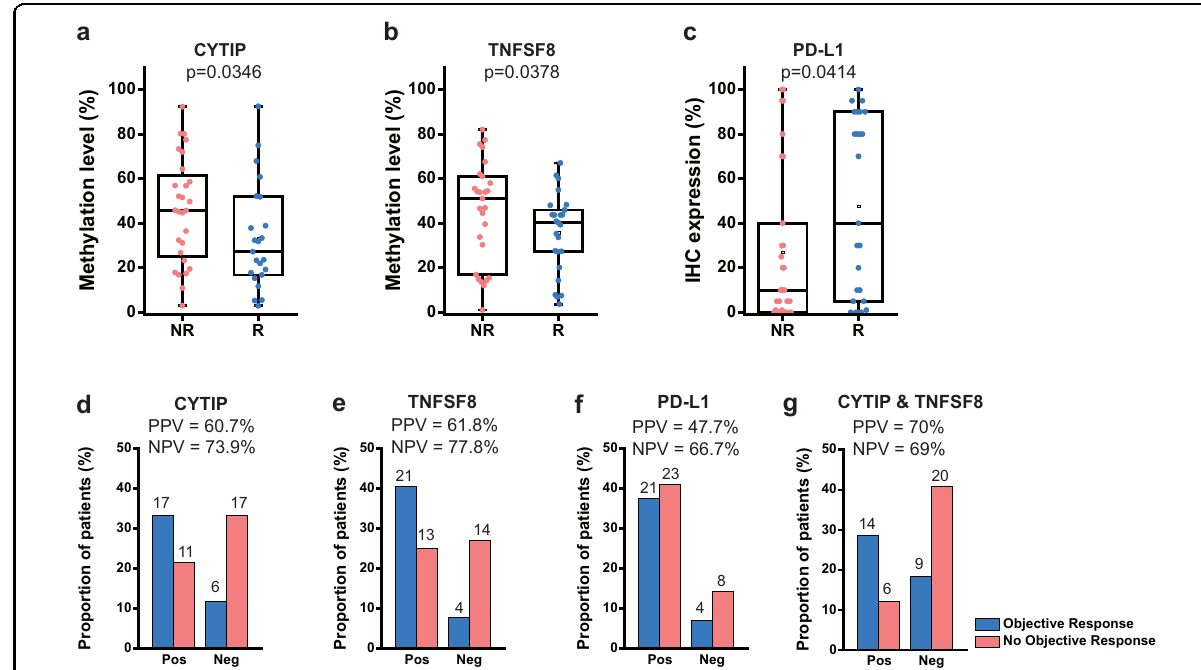
Fig. 4 Evaluation of pDMRs for CYTIP and TNFSF8 to predict the anti-PD-1 response. a , b Comparison of methylation levels of pDMR for CYTIP between responders (R) and non-responders a and those for TNFSF8 b in the validation cohort. c Comparison of the PD-L1 expression level between responders (R) and non-responders (NR) in the validation cohort. d , e Proportion of patients with objective response (blue) or no objective response (red) to anti-PD-1 therapy for the methylation level threshold of pDMR for CYTIP (40%) or that for TNFSF8 (50%), respectively. “ Pos ” indicates patients predicted to respond, and “ Neg ” indicates those predicted to not respond to anti-PD-1 therapy. f Analysis as for d , e with 1% of PD-L1 IHC expression level. g Analysis as for d , e with combined use of pDMRs for CYTIP and